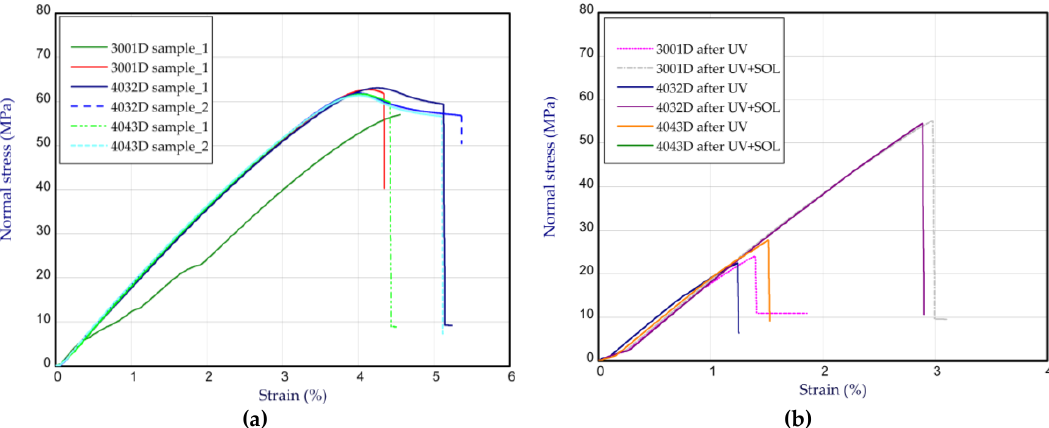
Figure 8. The curves of tension for samples 3001D, 4032D and 4043D before and after UV treatment. ( a ) pure samples, ( b ) single samples. Figure 9a,b present the tensile characteristics for sample 4032D admixed with GNP. Table 1. Characteristic parameters obtained in tensile tests for samples 3001D, 4032D and 4043D.